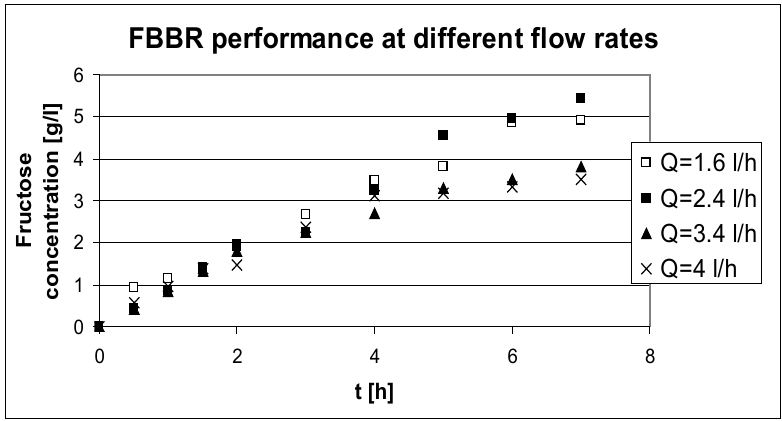
Figure 4. FBBR performance at different flow conditions; T = 40 °C, S E = 1g 0 cat